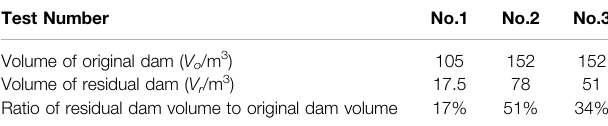
TABLE 3 | Ratio of the volume of residual dam to original dam.